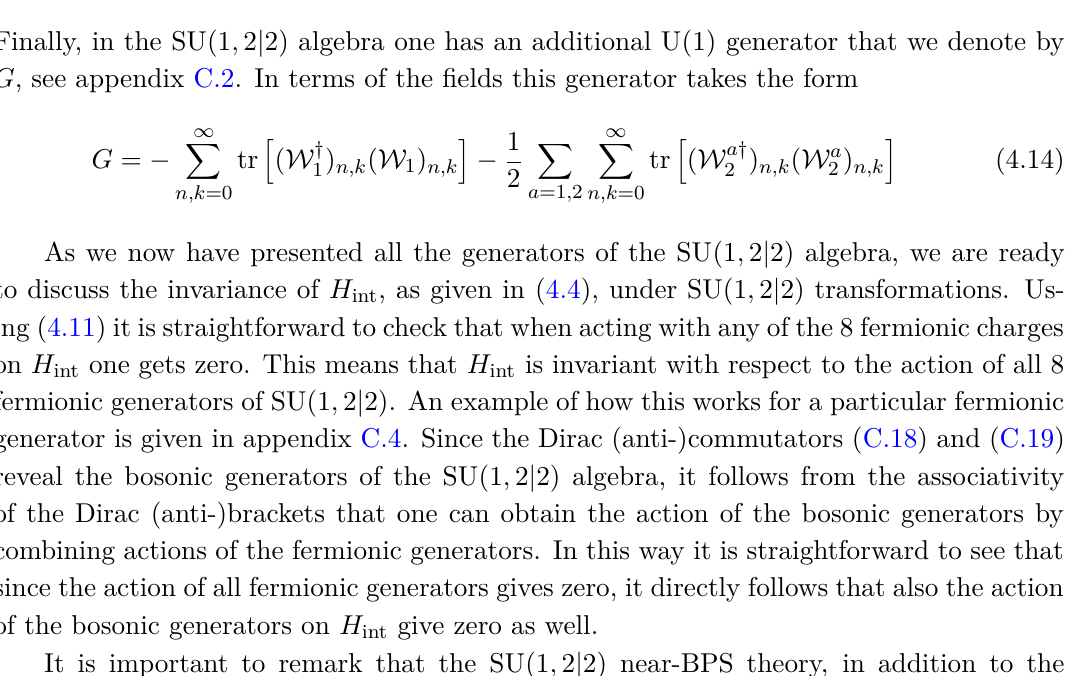
The R-charges of the blocks B † trivial R-charges. These are simply given